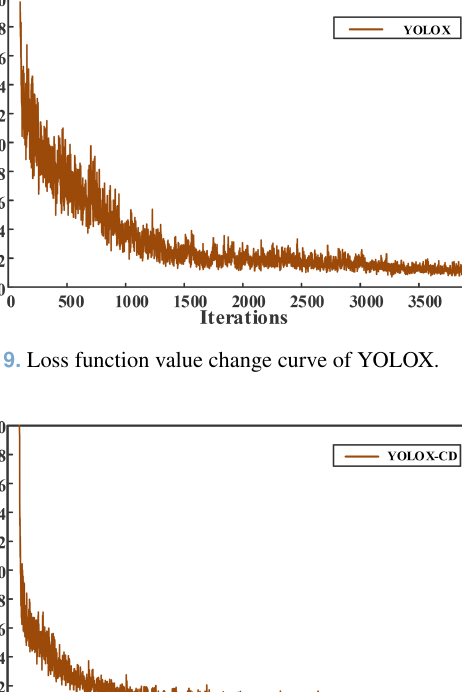
Table 2. Comparison of experimental results.